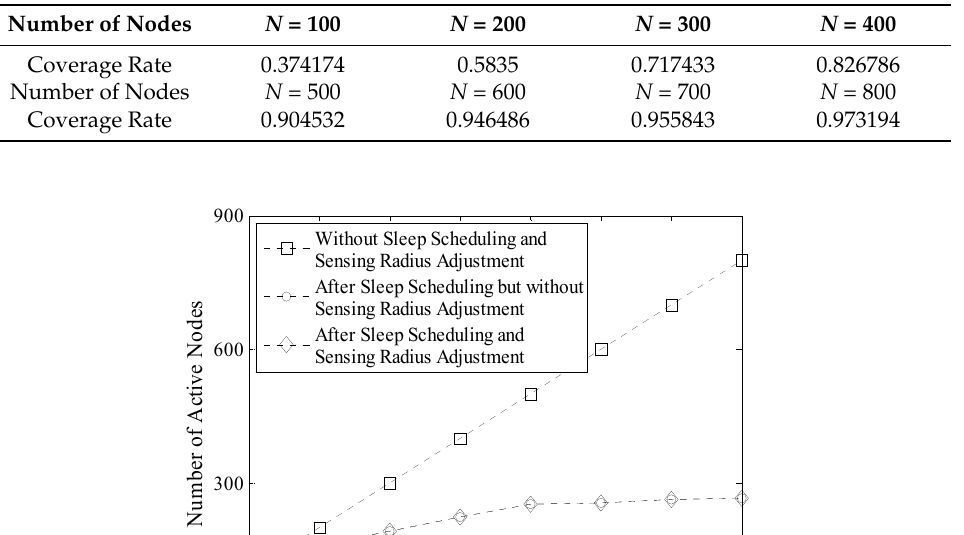
Figure 16. Redundancy on coverage (200 m × 200 m).